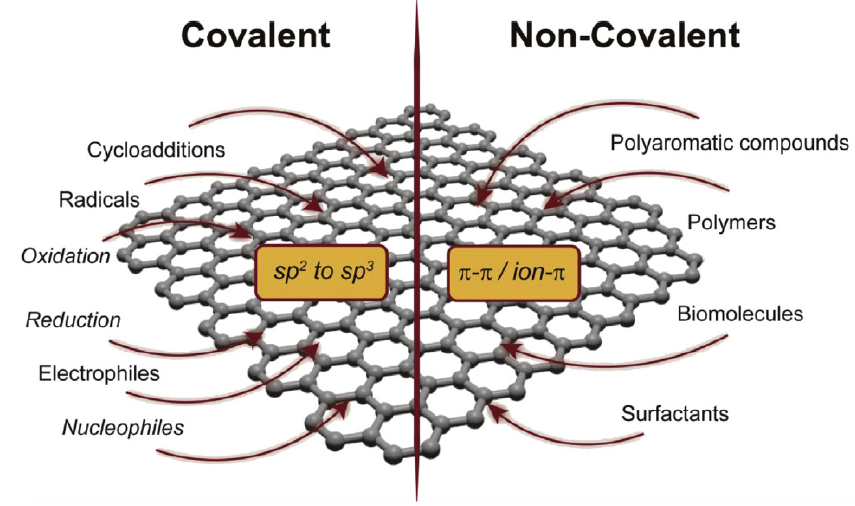
Figure 1. General representation of functionalization possibilities for graphene nanomaterials. Reprinted with permission from ref. [54]. Copyright 2019, Elsevier.